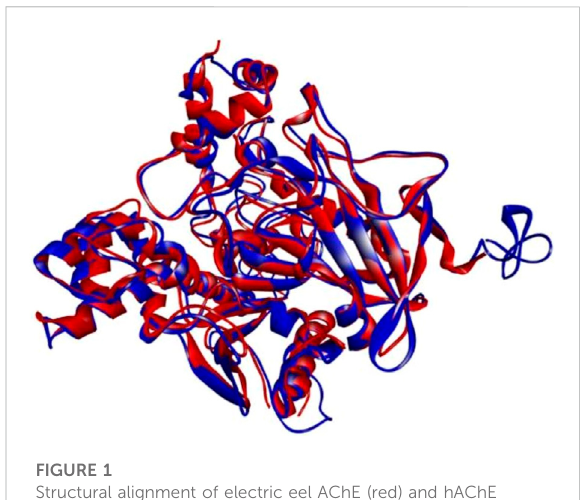
FIGURE 1 Structural alignment of electric eel AChE (red) and hAChE